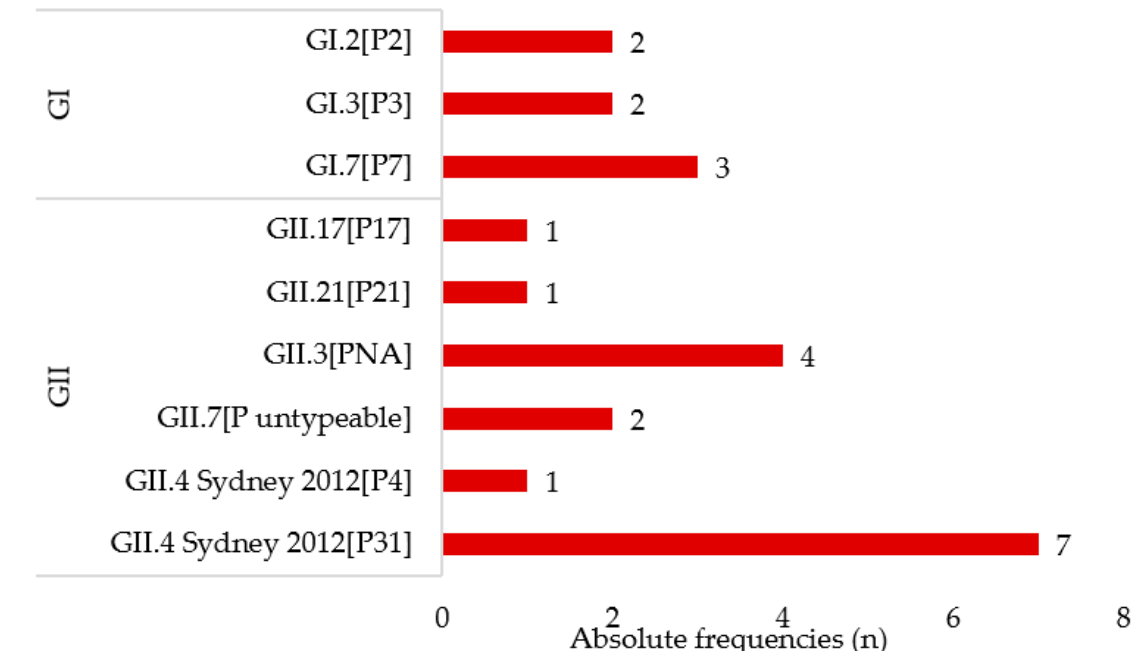
Figure 1. Distribution of norovirus genogroups and genotypes in samples collected from 23 chil- dren.